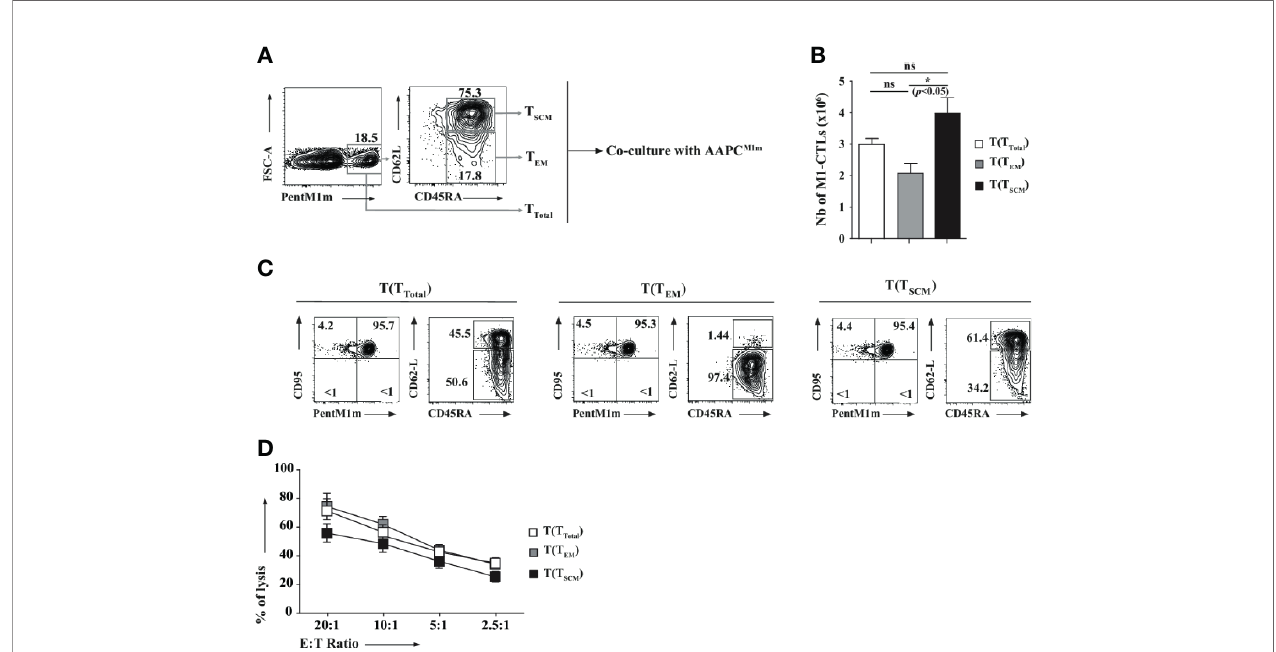
FIGURE 5 | T lymphocytes with stem cell-like and effector memory phenotypes carry different proliferative, differentiation and functional capacities. (A) Total CTLs obtained at D21 were stained with PentM1m (left panel). Puri fi ed M1-CTLs were used in T Total condition. Fluorescence-Activated Cell Sorting (FACS)-puri fi ed CD45RA + CD62L + and CD45RA + CD62L - M1-CTLs were described as T SCM and T EM respectively (middle panel) and ampli fi ed with AAPC M1m for 14 days. (B) M1-CTL absolute numbers obtained at the end of the co-culture (D35) from M1-CTL-derived T Total (T(T Total ), white histogram), T EM (T(T EM ), grey histogram) and T SCM (T(T SCM ), black histogram) are represented. Histograms were obtained from three healthy donors and shown with standard errors of means. Statistical tests ( t tests) were performed to compare both groups. Not signi fi cant (ns): p > 0.05, * p < 0.05. (C) Phenotype of T(T Total ), T(T EM ), and T(T SCM ) M1-CTLs. Relative percentages in a representative experiment are represented in each relevant quadrant. (D) M1-CTL cytotoxicity was assessed in standard 4-hour 51 Cr release assays. Target cells were T2 cells pulsed with 10µM of MART-1 A27L analogue peptide (M1m) or Flu Matrix Protein-derived peptide (FMP). Non-speci fi c lysis was always lower than 10% and removed to obtain the speci fi c lysis. The graph represents the results obtained with four healthy donors, each donor having been studied in three independent experiments. Data are represented with standard errors of means. Statistical tests (Friedman tests with Dunn ’ s post-tests) were performed to compare the different